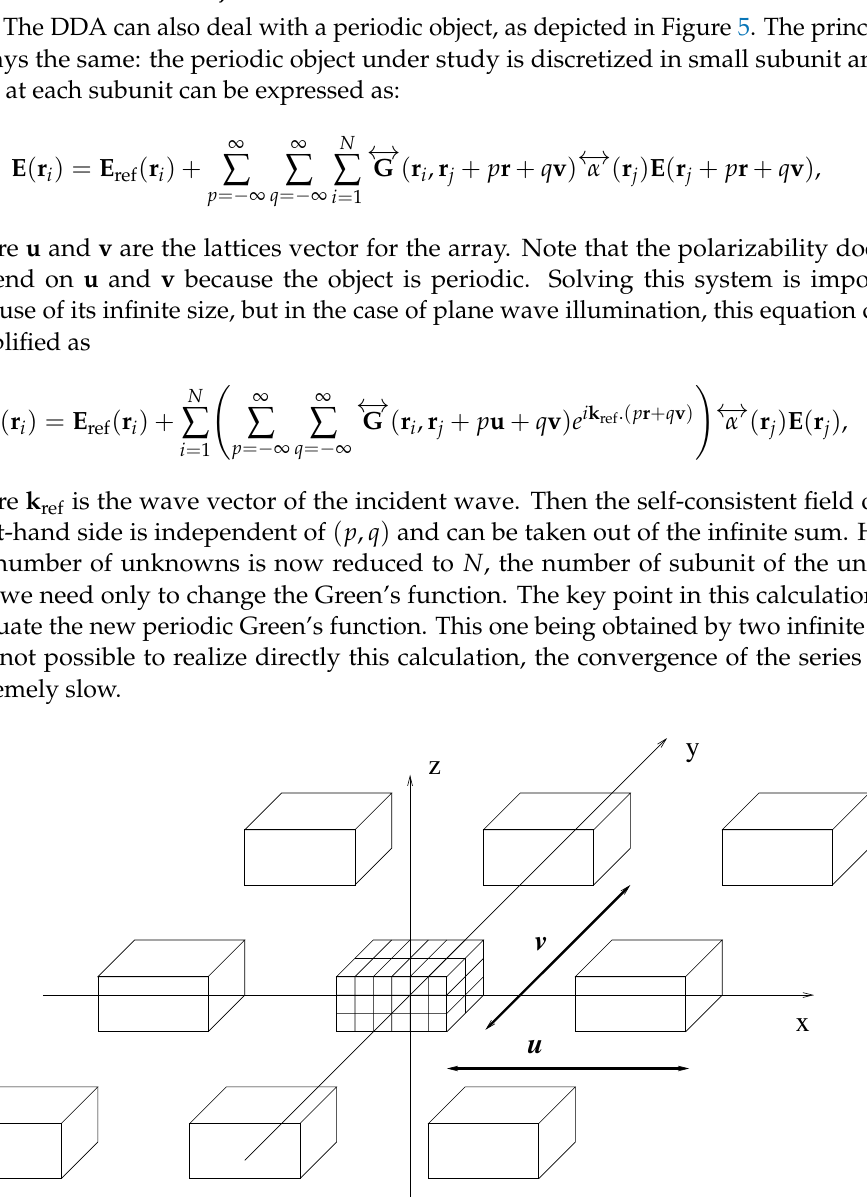
Figure 5. Bi-periodic diffraction gratings of period u and v in the ( x , y ) plane. Only the central object is discretized, the other elements are taken into account through the bi-periodic Green’s